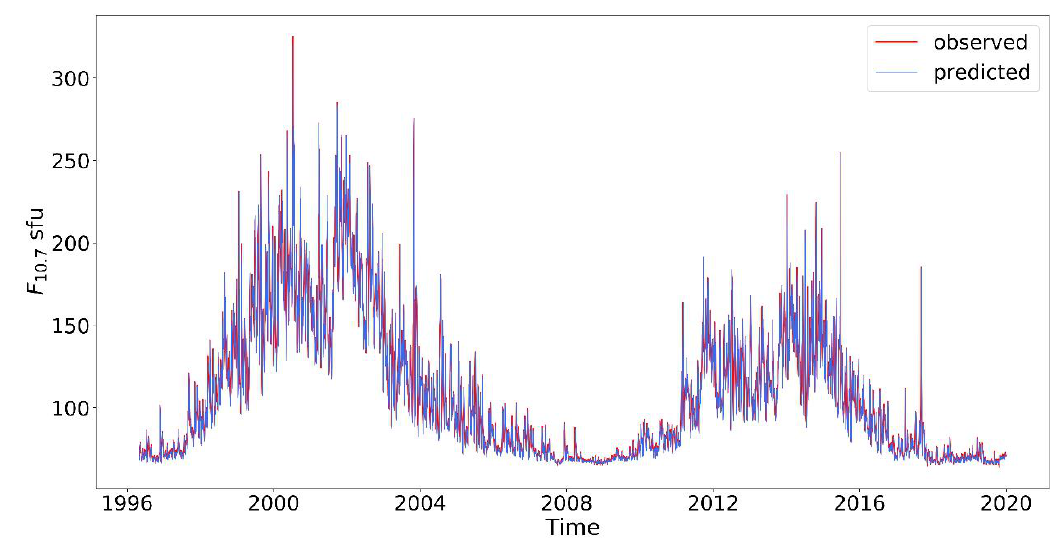
Figure 5. The same as Figure 4 but for the two-steps-ahead (2-day forecast) prediction of LSTM.